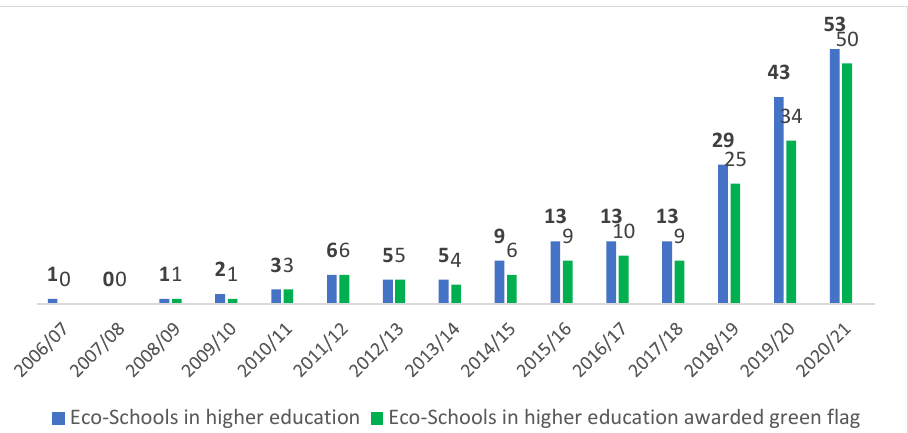
Figure 4. Eco-Schools in numbers: growth of Eco-Schools in Higher Education. Source: (ABAE 2021, 2022a).